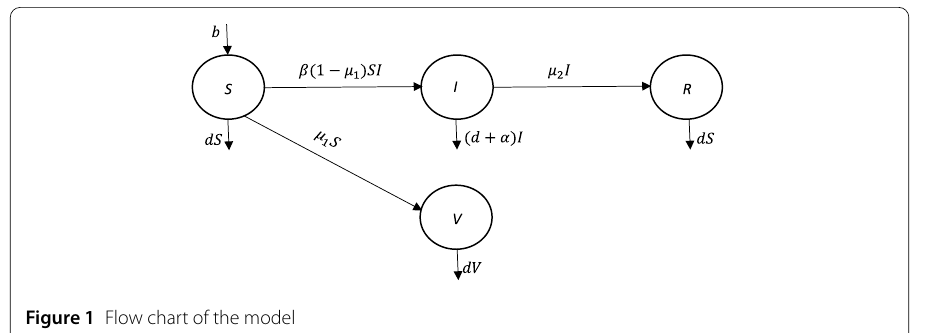
Figure 1 Flow chart of the